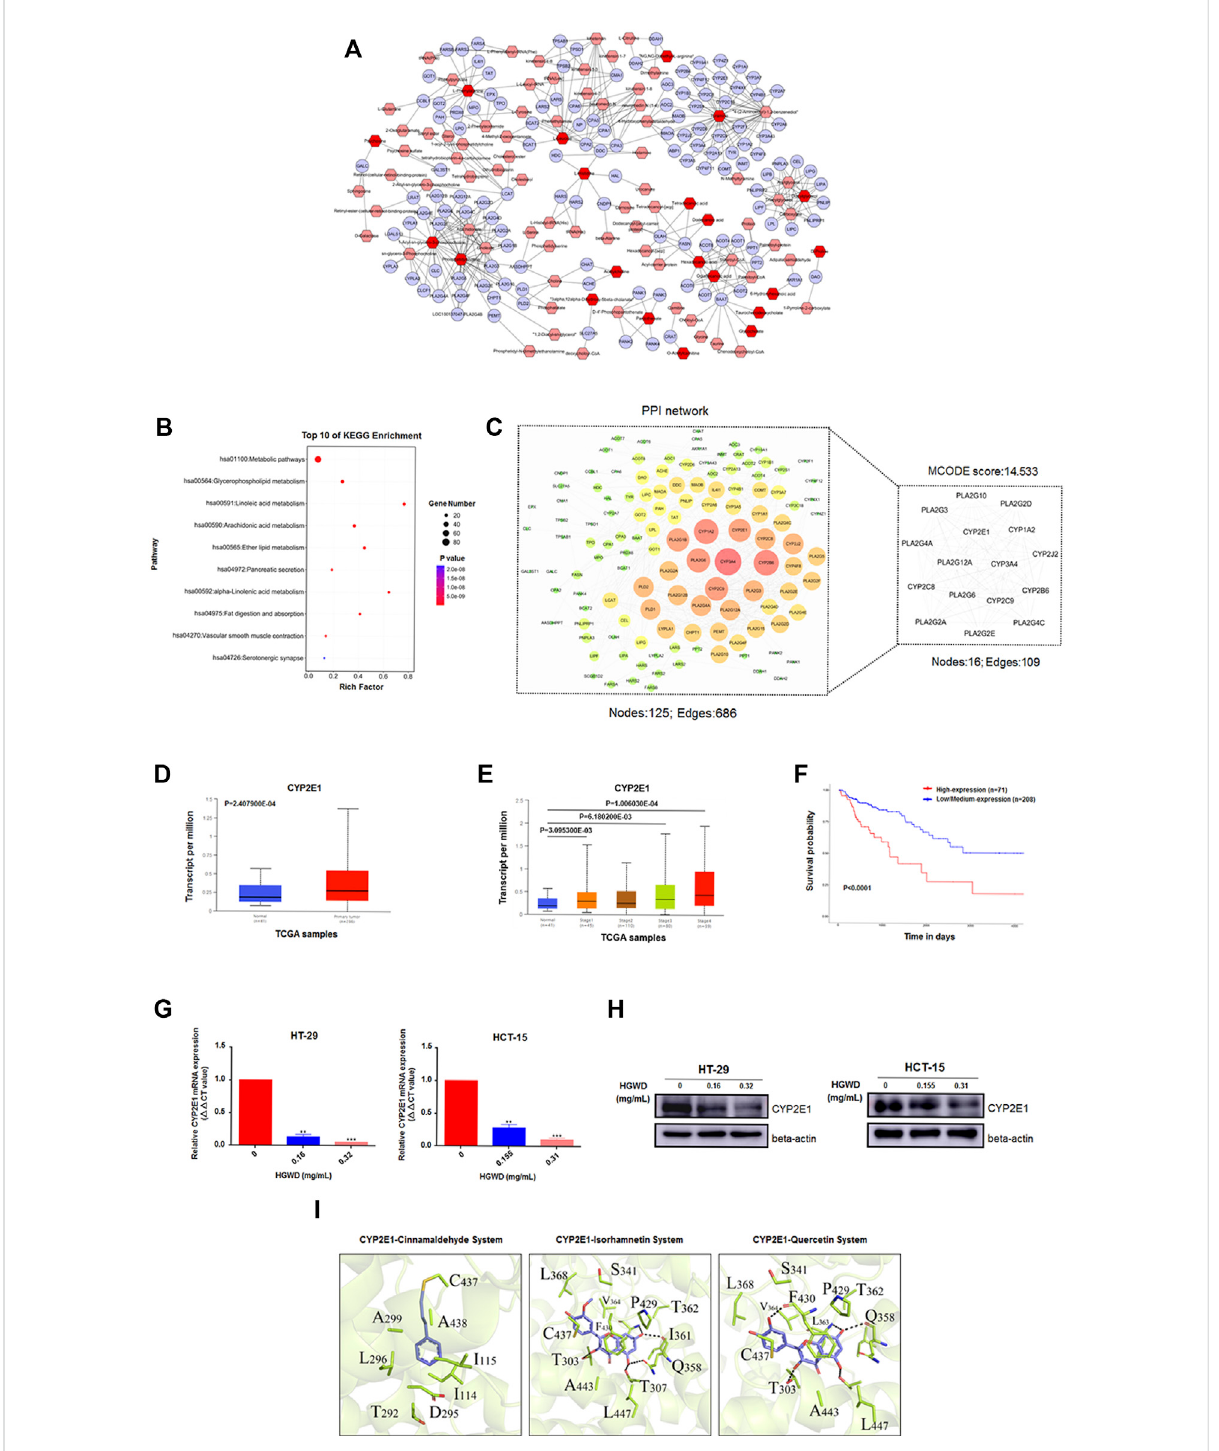
FIGURE 8 CYP2E1 is a candidate key target of HGWD in the treatment of CC (A) The network of potential biomarkers of HGWD for the anti-CC effect. It was constructed using MetScape, and the nodes represented related metabolites and targets regulated by signi fi cantly metabolites, and edges representedbiochemicalreactions. (B) Theabovetargetsregulatedbymetabolites wereenrichedinrepresentativesignaling pathways(KEGG)using DAVIDv6.8( p < 0.05). (C) ThePPInetworkofabovetargetsregulatedbymetaboliteswasestablished,andscreenedthecandidatekeytargetsby MCODE. (D – F) CYP2E1 was a potential key target in CC by UALCAN online database screening. (G,H) The expression levels of CYP2E1 were veri fi ed byqRT-PCRandWBinHGWD-treatedandcontrolCCcells,respectively.** p < 0.01and*** p < 0.001 (I)